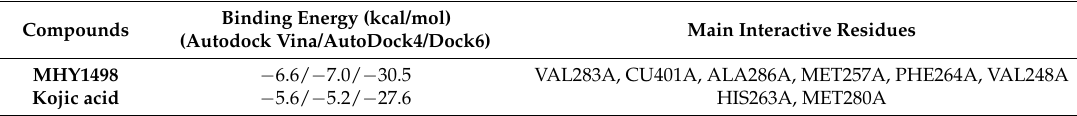
Table 3. Multi-docking scores and the major tyrosinase-interactive residues of MHY1498 and kojic acid. Compounds